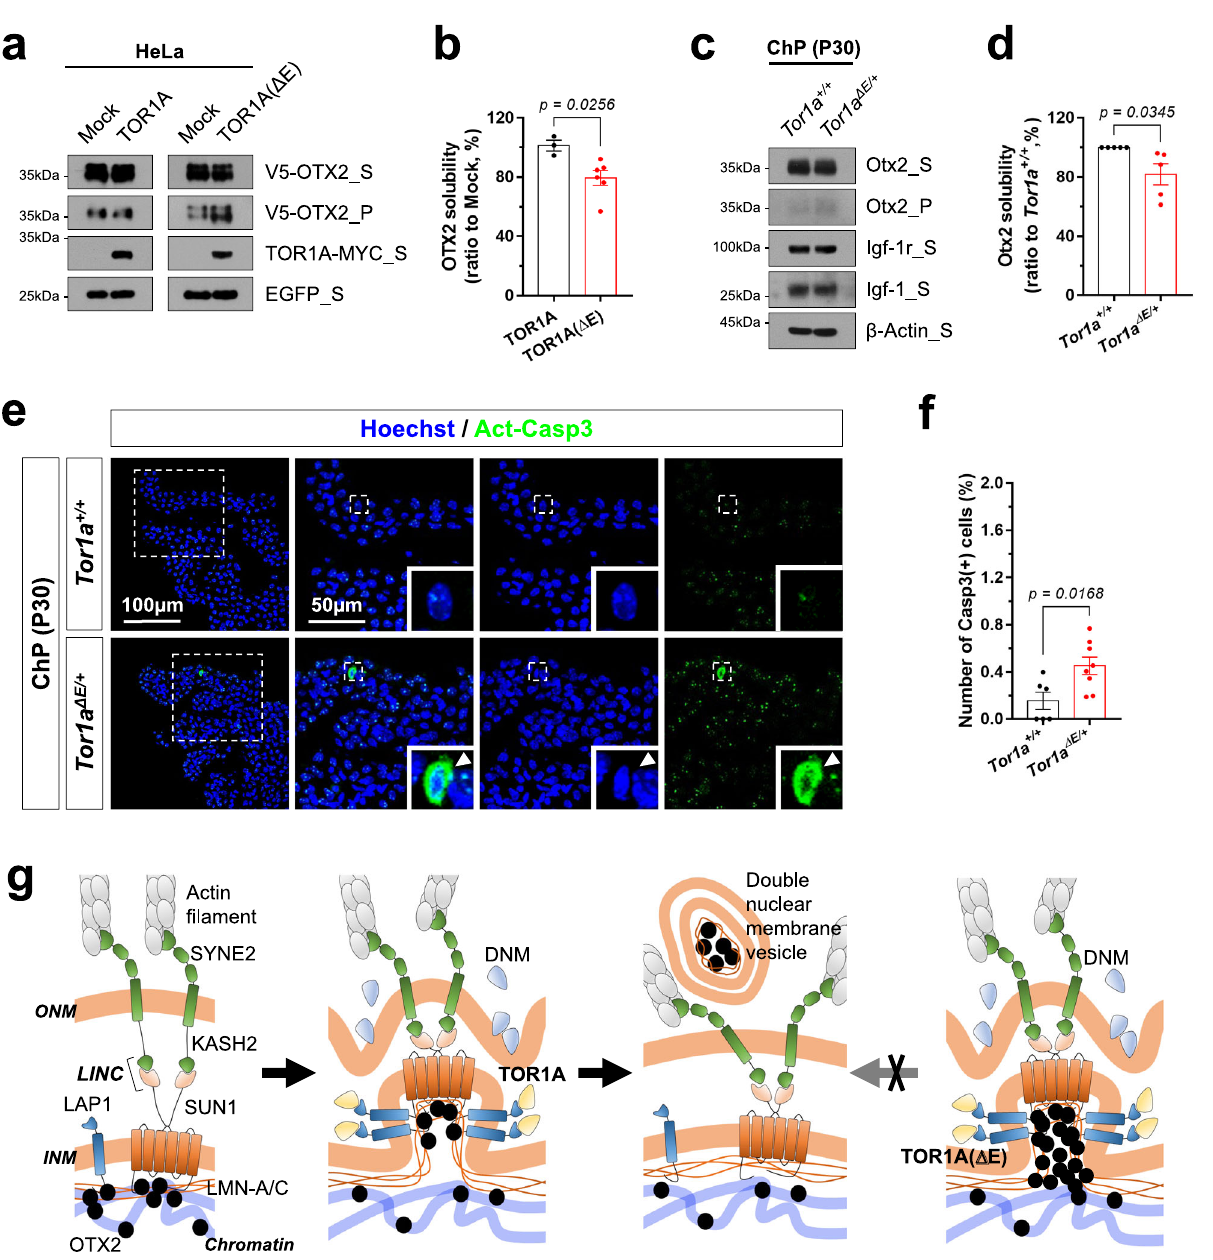
Fig. 9 | Excessive OTX2 forms insoluble aggregates in the nucleus. a HeLa cells overexpressingV5-OTX2togetherwithTOR1A-MYCorTOR1A Δ E-MYCwerelysedin RIPAbuffer.Thesolublesupernatantfractions(S)ofthecelllysateswereseparated frominsolubleprecipitatefractions(P)bycentrifugation.RelativelevelofV5-OTX2 in each fraction were then examined by WB with anti-V5 antibody. The levels of EGFP, which is co-transcribed with V5-OTX2 in a same mRNA, and MYC-tagged TOR1A and TOR1A Δ E was also investigated by WB. b OTX2 solubility was deter- mined by dividing band intensity of V5-OTX2_S by that of total (V5-OTX2_S+V5- OTX2_P). Relative solubility values to Mock (pCAGIG)-transfected samples were obtained and shown in the graph. The graph shows mean OTX2 solubility values. ErrorbarsdenoteSEMobtainedfrom4independentexperiments. c ChPcellswere isolatedfromP30 Tor1a +/+ and Tor1a Δ E/+ mice( n =4,each)andSandPfractionswere separated from the cell lysates. Otx2 in each fraction were then detected by WB with anti-Otx2 antibody. The levels of Igf-1, which is secreted by the ChP cells, and